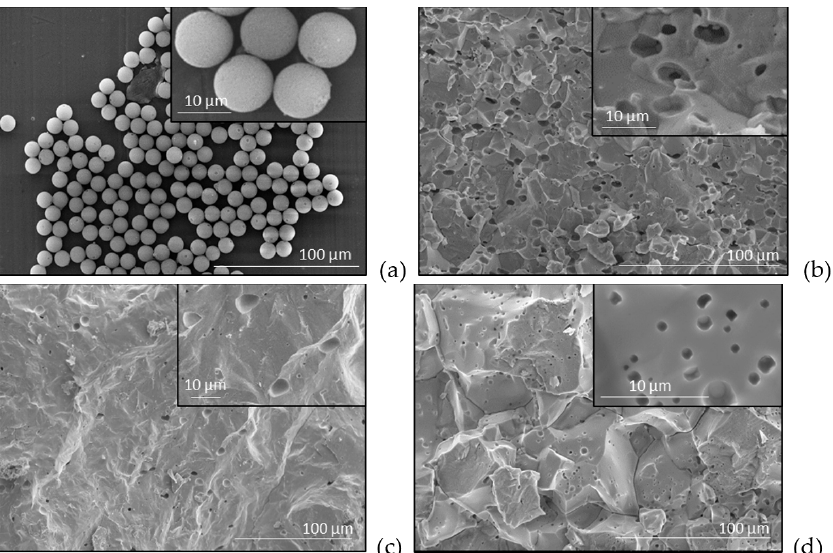
Figure 1. SEM micrographs in fractured fresh surfaces of the PMMA spheres used as pore forming agent ( a ) and for the sintered BaTiO 3 ceramics with elongated porosity ( ∼ 10 vol.%) obtained by the addition of PMMA spheres uniaxially pressed ( b ), or isostatically pressed ( c ) and for a BaTiO 3 ceramic realized without any polymeric addition, showing natural occurred spherical porosity (4 vol.%), as result of imperfect sintering ( d ).